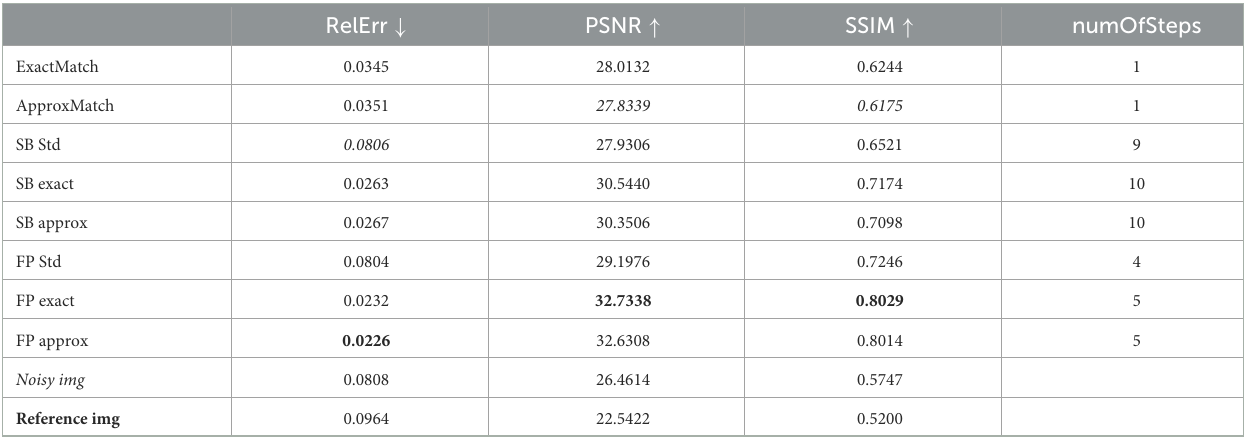
TABLE 3 Case 3. A more realistic case in which the target image is acquired with 9 % noise at a distance of –5 mm from the original image, which has 3 %